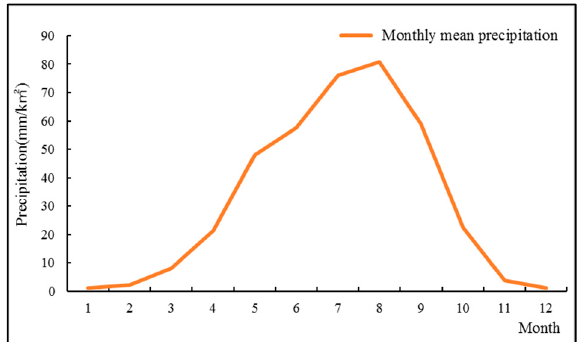
Figure 2. Monthly mean precipitation of the Huangshui River basin (1960–2017). Table 1. Comparison of the runoff in different seasons.